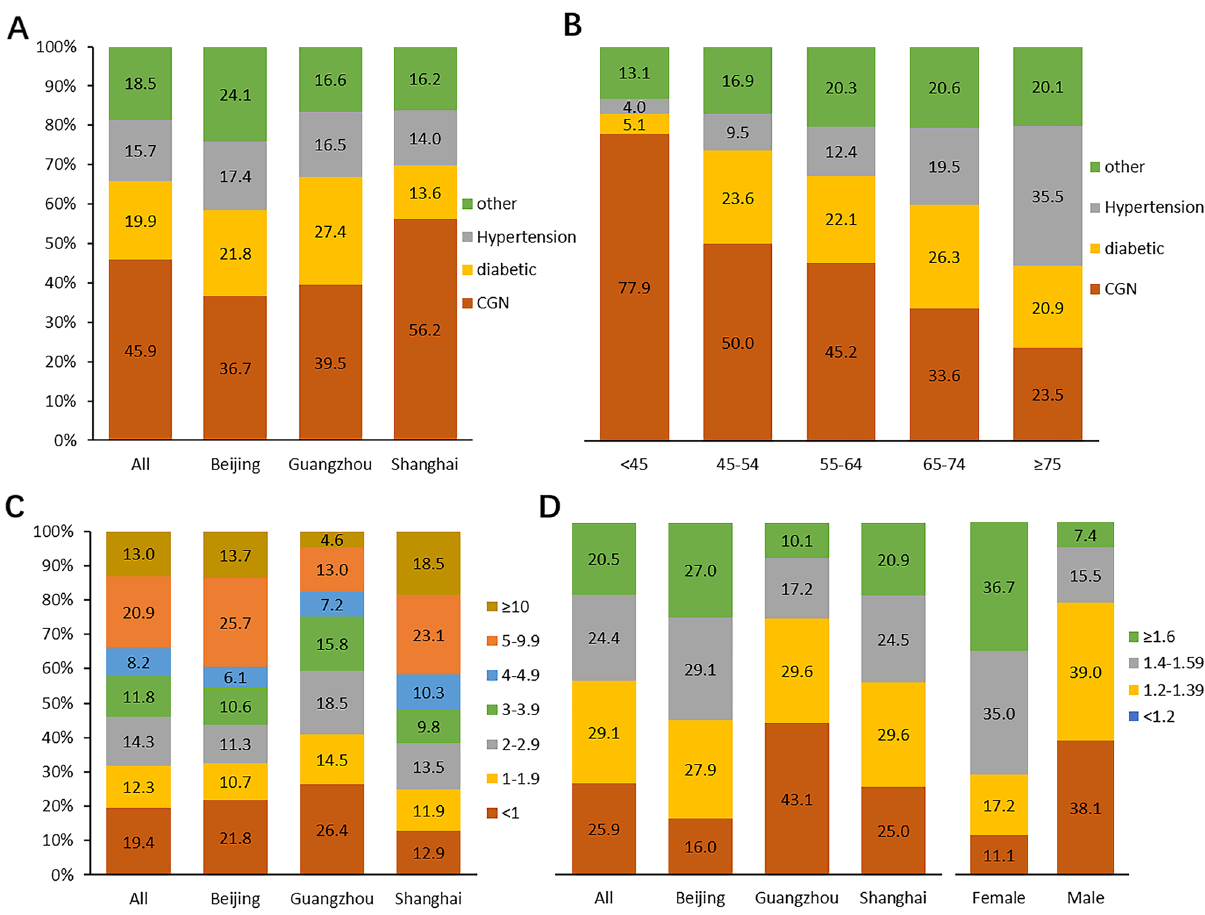
Figure 1. The distribution of the assigned primary ESKD causes, dialysis vintage and spKt/V. ( A ) The distribution of the assigned primary ESKD causes stratified by city group; ( B ) the distribution of the